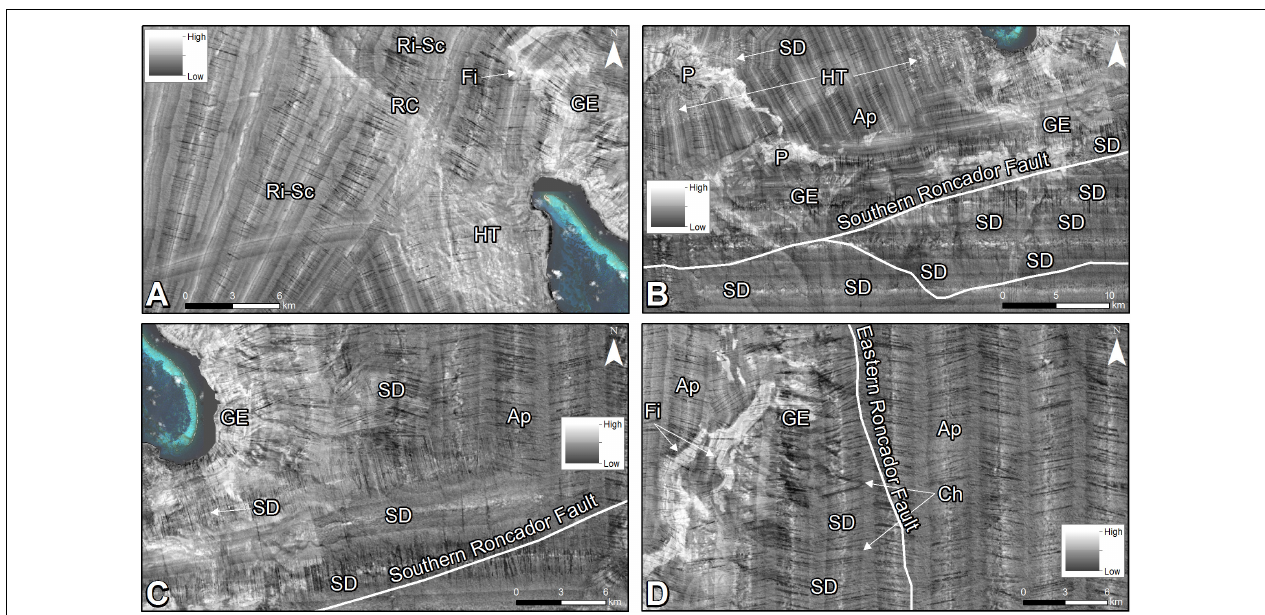
FIGURE 7 | Backscatter signal of the seafloor in the same sector shown in Figure 6 . (A) In the northwestern sector of Roncador, the hummocky terrain (HT) is characterized by a mixture of intermediate and high values of seafloor reflectivity. The thalweg of Roncador Canyon (RC), the gullied escarpment (GE) and the fissure (Fi) exhibit high backscatter values. (B) Southern escarpment of Roncador where the slope deposits (SD) show low backscatter signal, demonstrating their depositional character. The two pinnacles (P) at the top of the escarpment exhibit high values of reflectivity. (C) Gullied escarpment (GE) in the southeastern sector of Roncador characterized by very high backscatter, and extensive slope deposits (SD) at the foothills exhibiting intermediate to low acoustic reflectivity. (D) A fissure (Fi) at the top of the eastern escarpment of Roncador is evident by very high backscatter values. The satellite image covers the reef constructions shallower than –40 m and the permanently emerged areas (cays). Ri-SC, terrain with minor ridges and scarps corresponding to large-scale landslides deposits; Ap, archipelagic apron; Ch, channel. See Figure 4 for location.